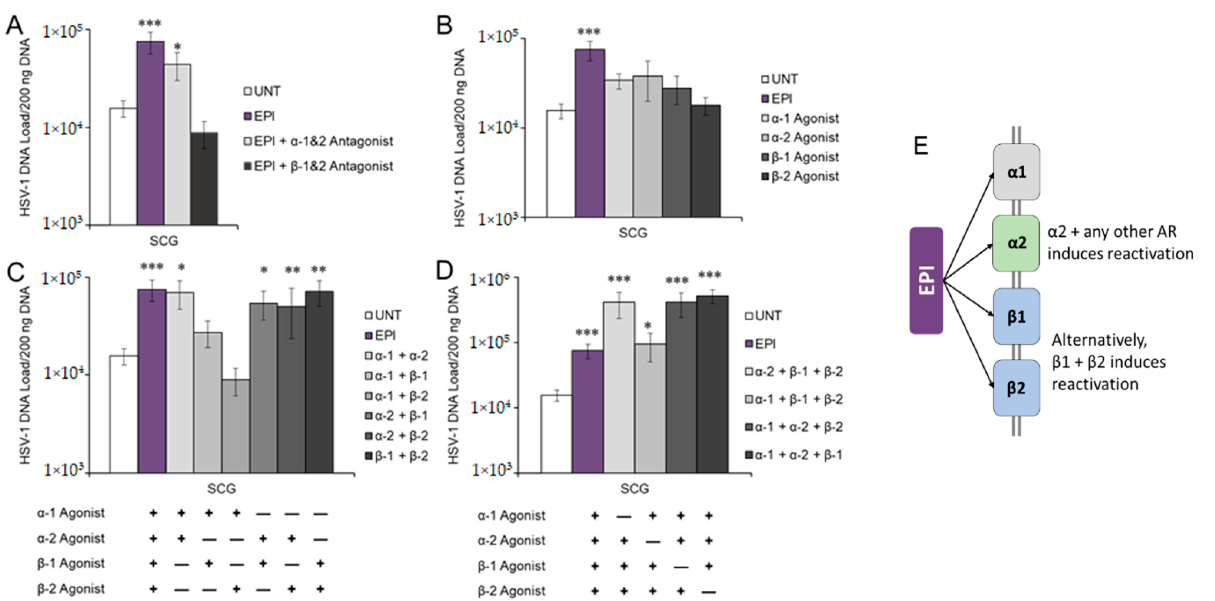
Figure 2. Multiple adrenergic receptors are required for EPI-induced HSV-1 reactivation in sympa- thetic neurons. ( A ) Reactivation of HSV-1 with EPI in primary adult murine sympathetic SCG cultures either alone, with nonspecific α -AR antagonist (phentolamine), or nonspecific β -AR antagonist (timolol). ( B ) Reactivation of HSV-1 in primary adult murine SCG cultures with either EPI, α -1 agonist (phenylephrine), α -2 agonist (clonidine), β -1 agonist (dobutamine), or β -2 agonist (terbutaline). ( C ) Reactivation of HSV-1 in primary adult murine SCG cultures with either EPI or a combination of two adrenergic agonists utilized in Figure B. ( D ) Reactivation of HSV-1 in primary adult murine SCG cultures with either EPI or a combination of three adrenergic agonists utilized in Figure B. Reactivation was quantified in A–D by viral DNA collected 24 h posttreatment measured by qPCR. ( E ) Data summary: activation of α 2 and any other AR induces HSV-1 reactivation in adult sympa- thetic SCG neurons. Alternatively, activation of β 1 and β 2 simultaneously can also induce reactiva- tion. Data are means ± SEM, n > 6; results were compared to untreated cultures by ANOVA and post hoc Tukey’s HSD; * p < 0.05; ** p < 0.01; *** p < 0.001.